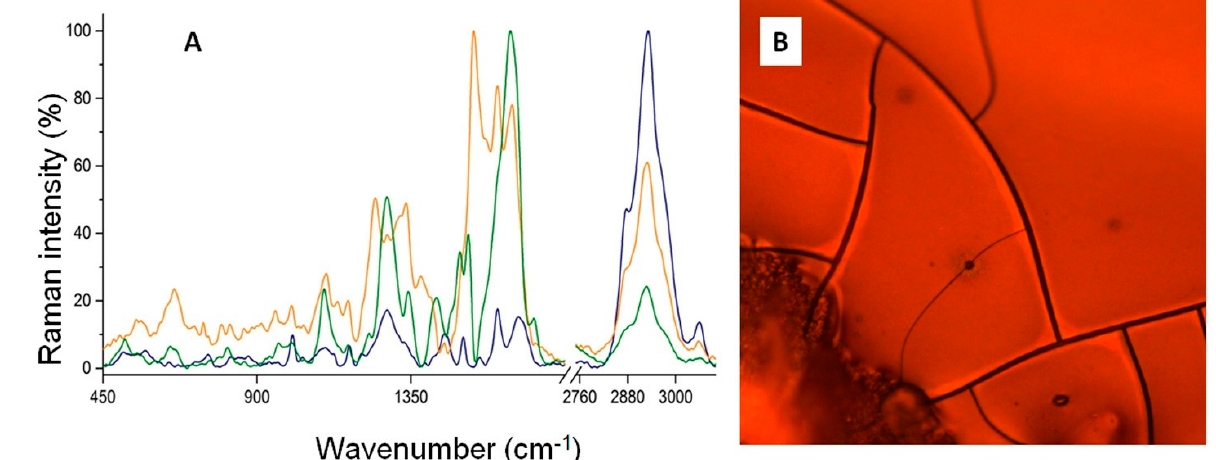
Figure 5. ( A ) Raman spectra of native bLTF (blue), AgLTF45 (green), and AgLTF450 (orange), ( B ) The picture of AgLTF1200 complex under microscope objective, where blue arrows show the places of protein degradation.